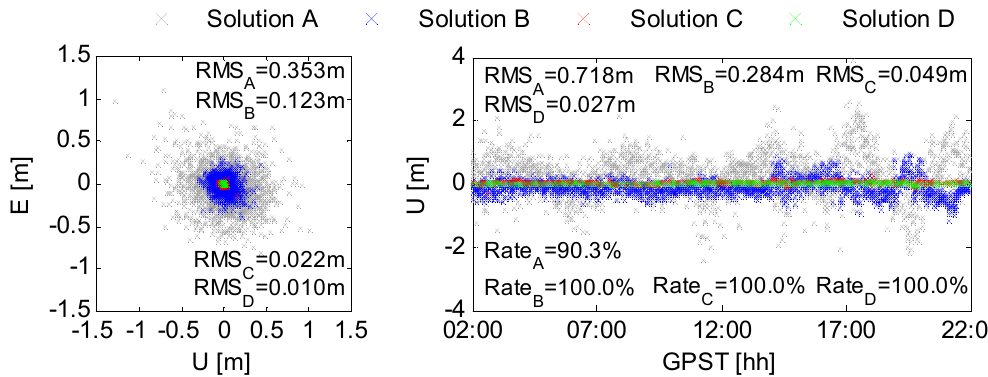
Figure 13. Single-epoch PPP ambiguity-fixed results at P565 with GPS/Galileo triple-frequency data.